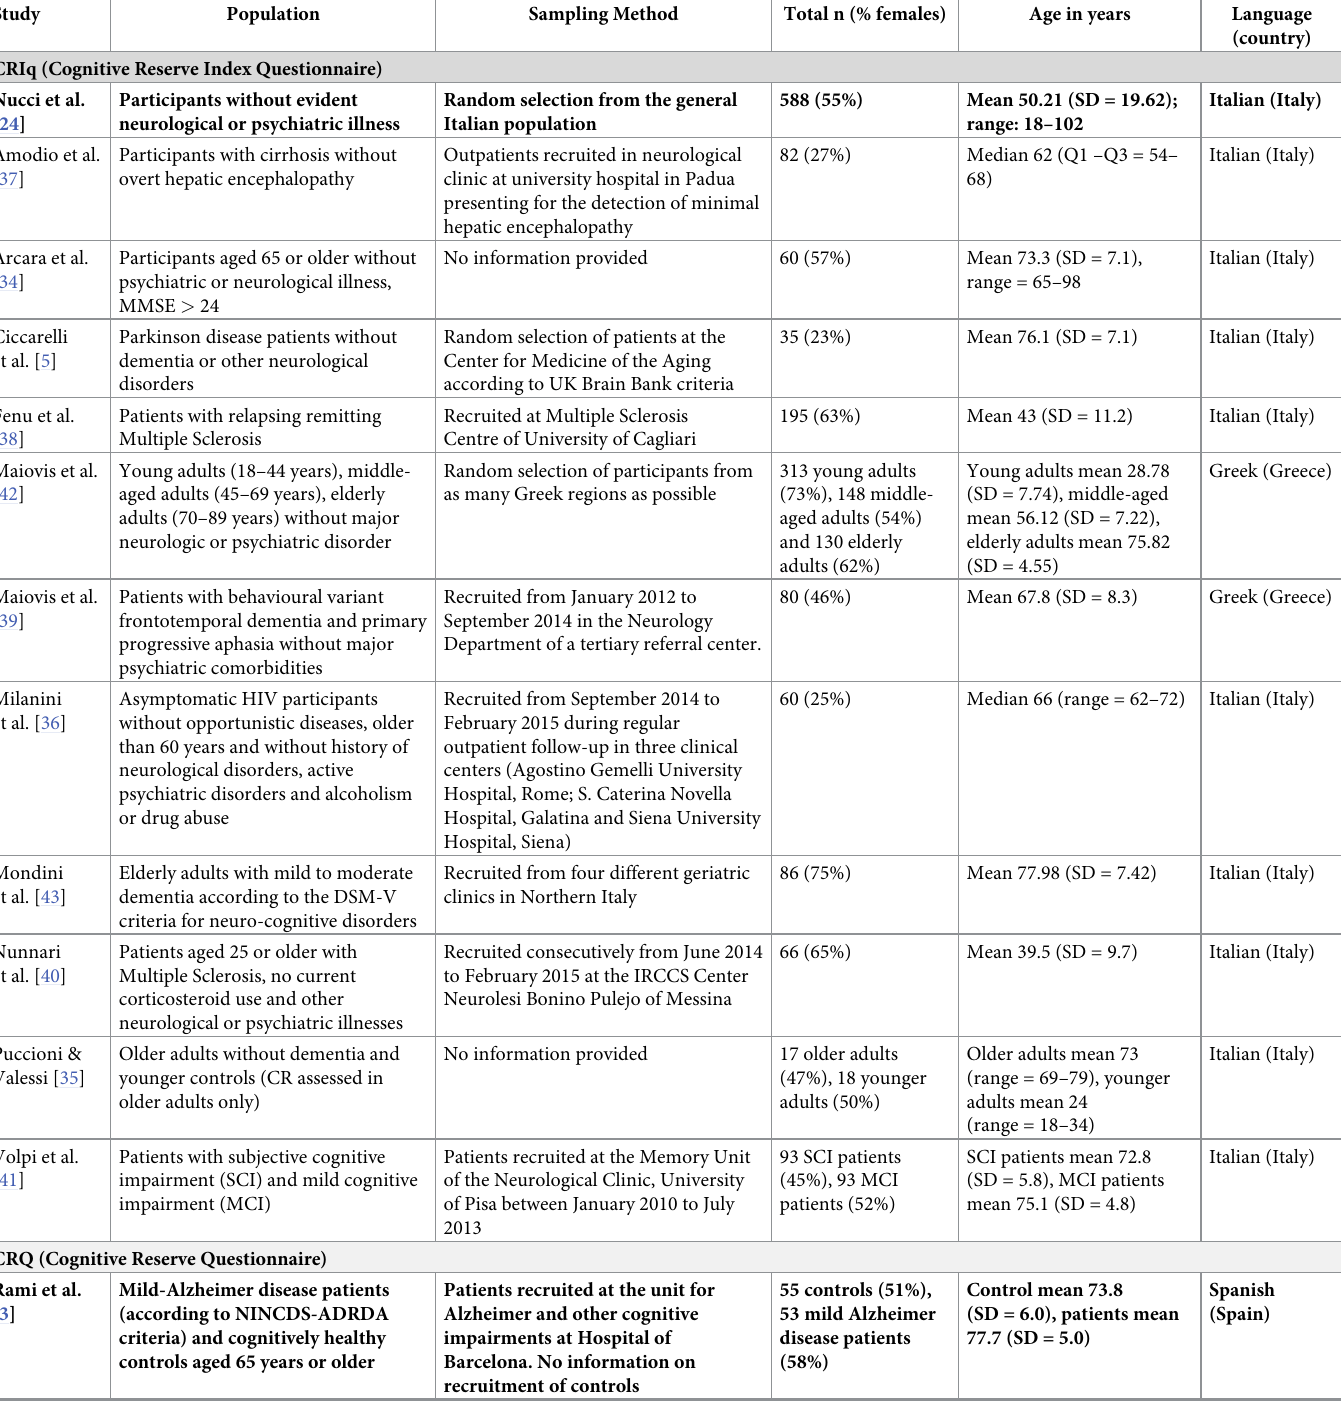
Table 2. Studies included in the systematic review by questionnaire. The study on the development of the questionnaire is marked in bold. SD = standard deviation; Q = quartile; DSM = diagnostic and statistical manual; NINCDS-ADRDA = National Institute of Neurological and Communicative Disorders and Stroke and the Alzhei- mer’s Disease and Related Disorders Association; MMSE = mini mental state